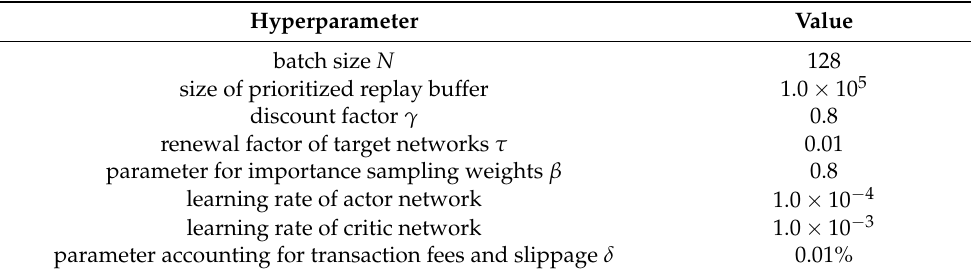
Table 1. Hyperparameters of